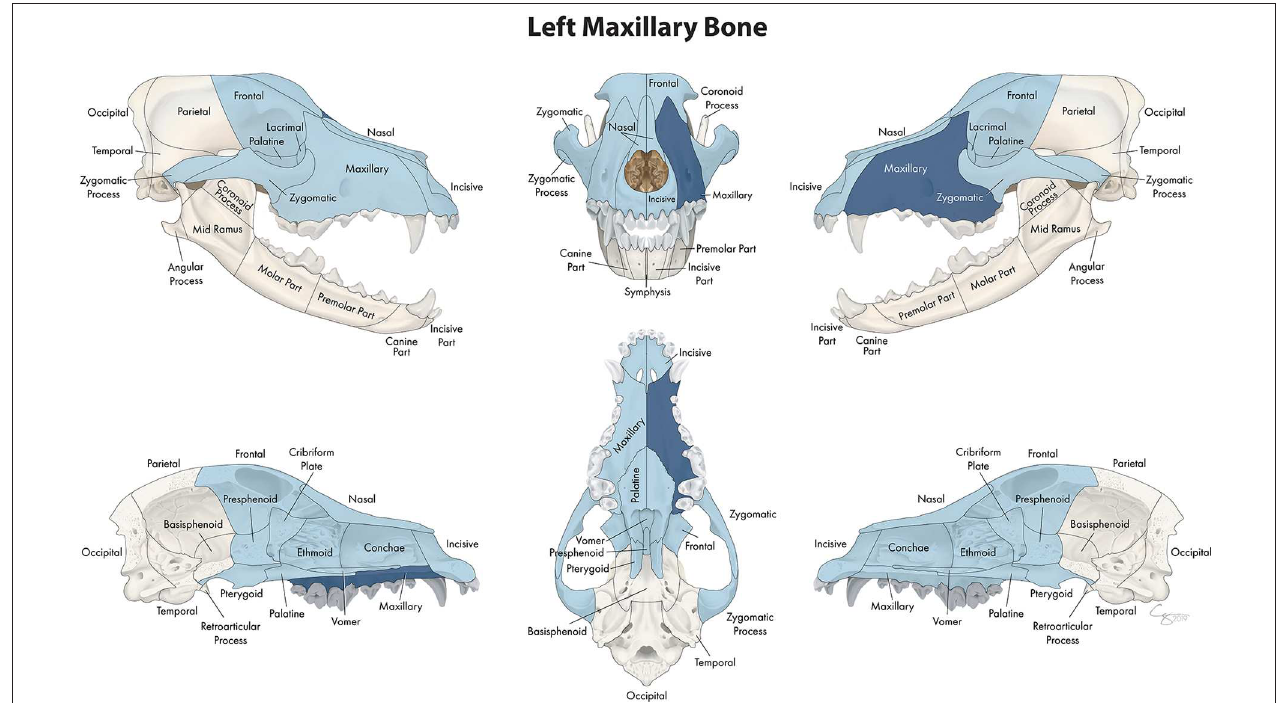
FIGURE 6 | Significant bones or regions fractured concurrently with the maxillary bone. When the maxillary bone was the region of interest, many other bones of the skull base/cranial vault and midface, both on the ipsilateral and contralateral side, fractured concurrently. Although the left maxillary bone is shown, when the right maxillary bone was the region of interest, a mirror image of concurrently fractured locations applied.